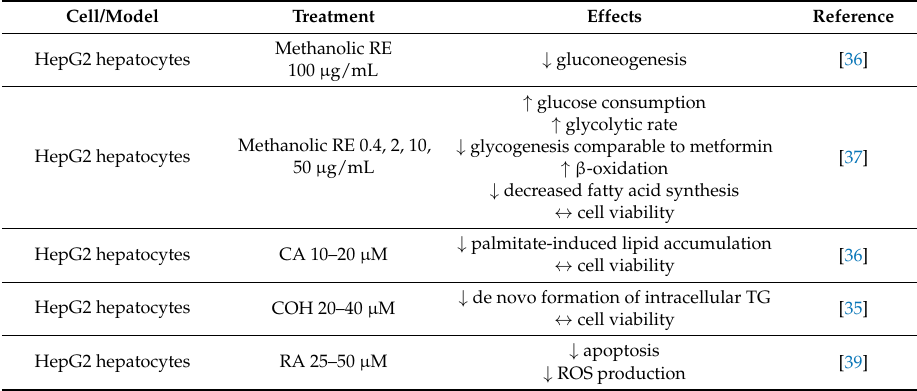
Table 3. Anti-diabetic Effects of Rosemary Extract and its Main Polyphenolic Constituents: in vitro studies